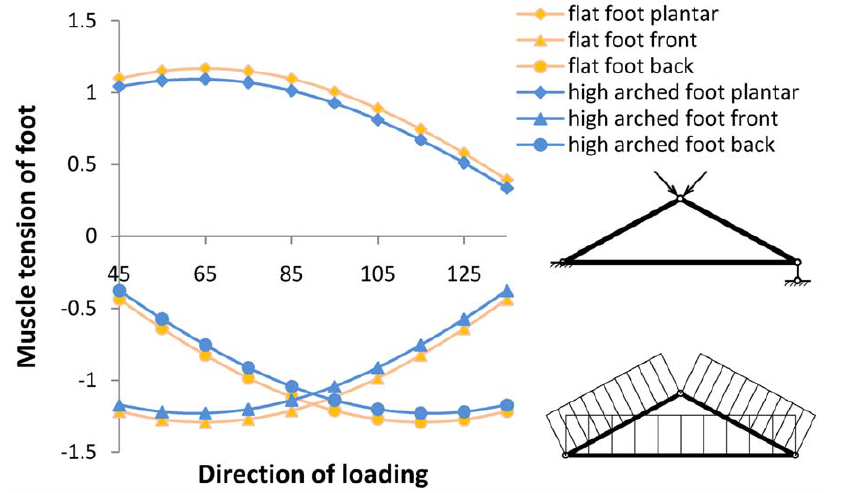
Figure 3. Relationship between muscle tension and load. The foot arch is here simplified as a triangle truss, of which the truss width (foot length) is standardized as 1, the truss height (foot arch height) is the foot arch index, and the magnitude of the concentration force is 1. Its direction is changed from 45 degrees to 135 degrees, and its point application is at the top of the truss.